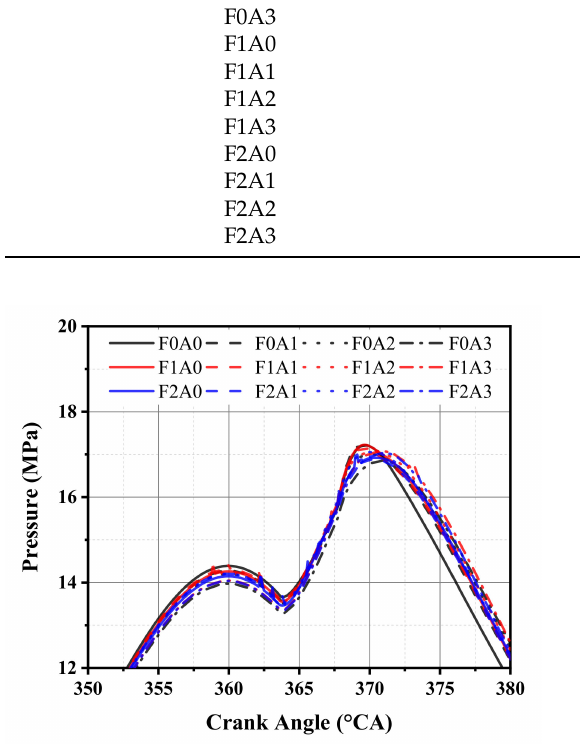
Figure 4. The comparison of pressure in the cylinder of different grid numbers.